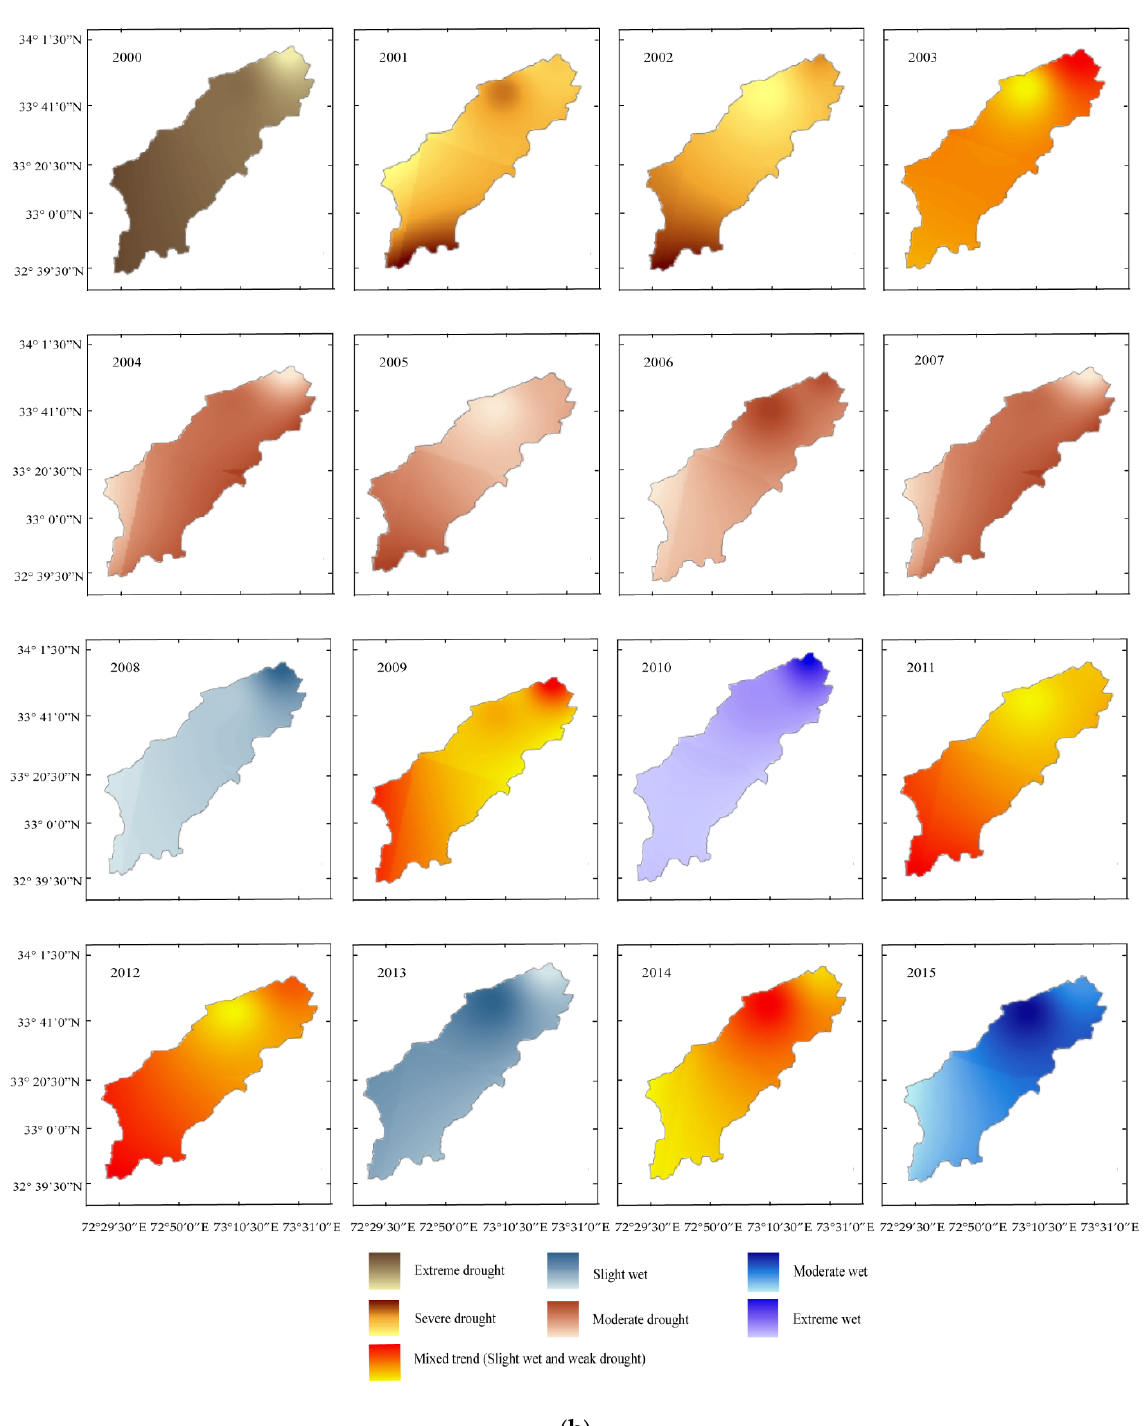
Figure 2. ( a ) Spatiotemporal variations of RDI-12 from 1984 to 1999. ( b ) Spatiotemporal variations of RDI-12 from 2000 to 2015.